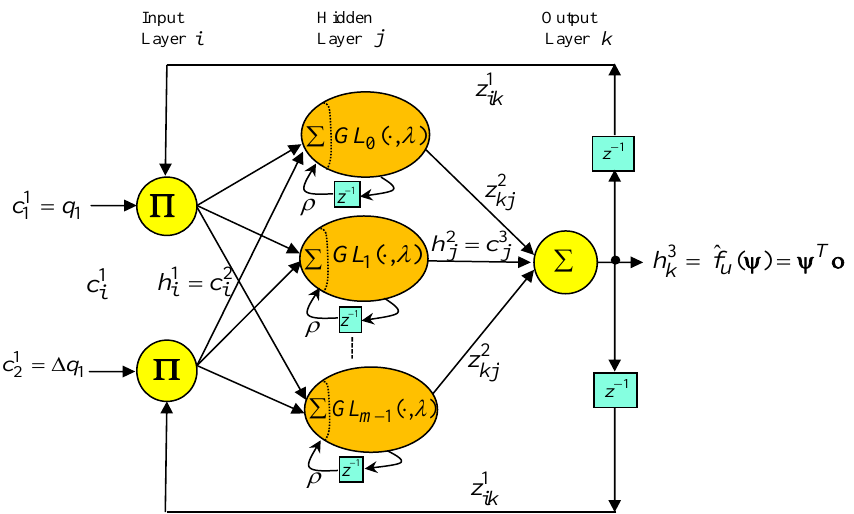
Figure 4. Makeup of the three-layer amended recurrent Gottlieb polynomials neural network.